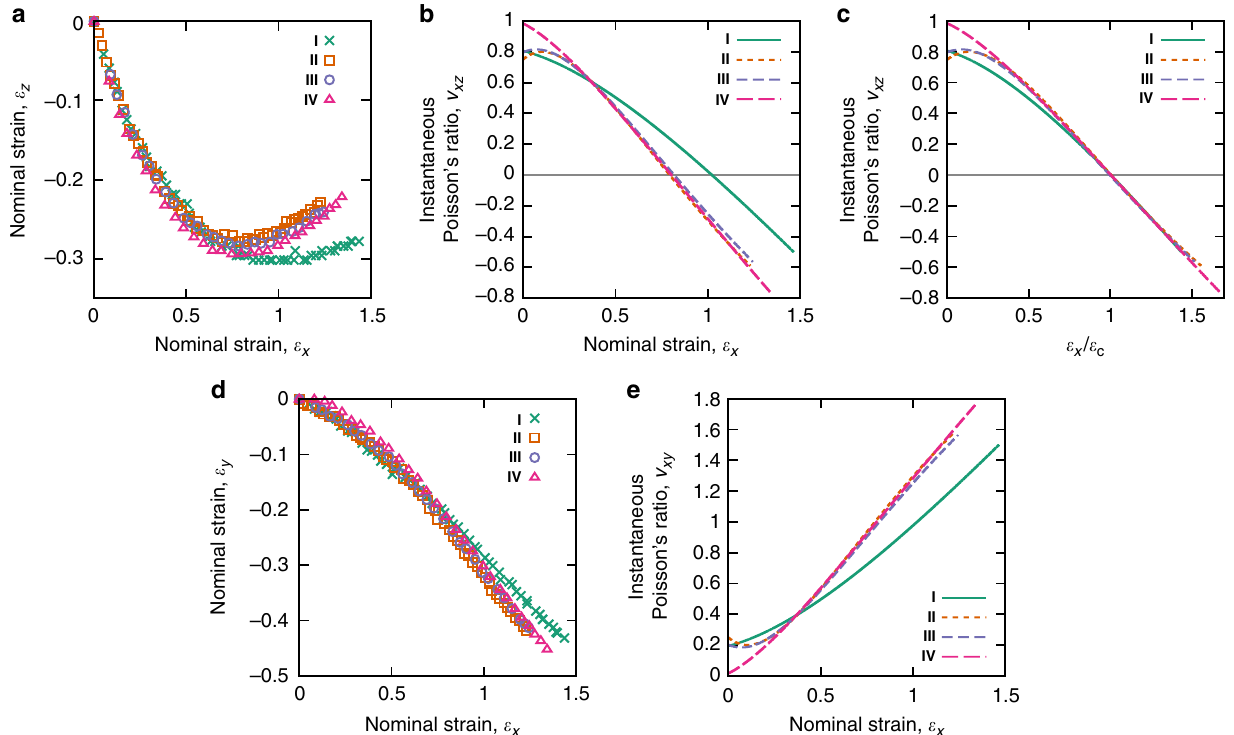
Fig. 4 Measured strains and instantaneous Poisson ’ s ratio behaviour. a For each of the various samples deformed under conditions I – IV the strain ε z initially decreases. Beyond the minimum the behaviour becomes auxetic. b Strain-dependent Poisson ’ s ratios extracted from a shows that ν xy in general monotonically decreases and becomes negative above a critical strain, ε c , speci fi c to each test condition. c The instantaneous Poisson ratios plotted relative ν xy plane and e the calculated instantaneous ε xz in all cases are largely identical. d The measured principle strains in the c showing that the behaviour of PRs, ν xy , for all test conditions I – IV . In each case ν xy begins close to zero and increases with imposed strain, ε x